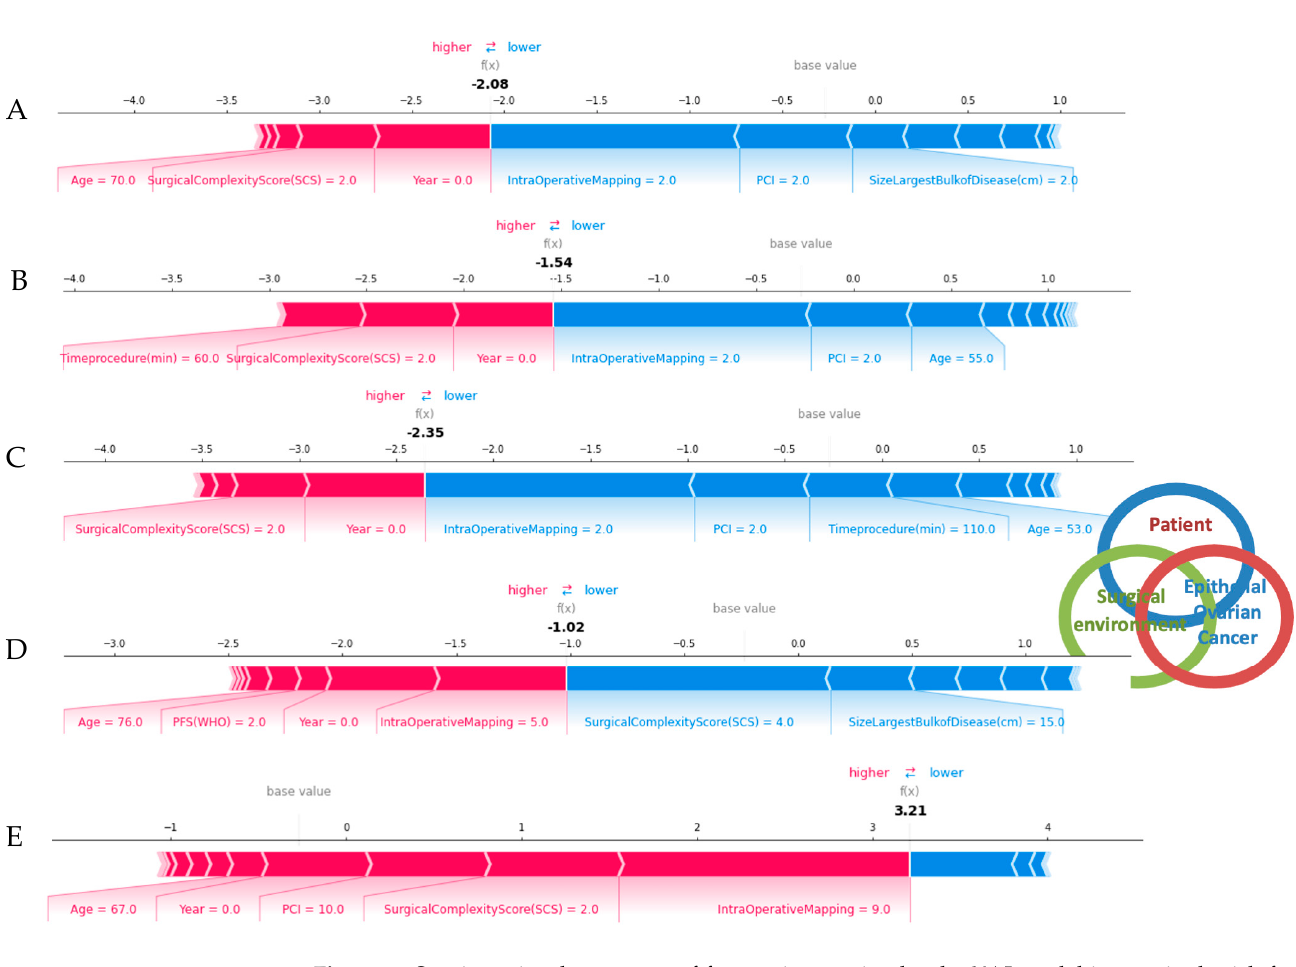
Figure 5. Succinct visual summary of feature integration by the XAI model into a single risk for R0 resection prediction. The SHAP force plots illustrate examples of explained risks for individual patients. For R0 resection risk, blue features have values that increased the risk, while red features decreased the risk. The combination of impacts of all features is the predicted R0 prediction risk. ( A – D ) The odds for R0 resection range between 1.54 and 2.35 times higher than expected ( E ). The odds for incomplete cytoreduction are 3.21 times higher than expected. Each feature impact value represents the change in risk when that feature’s value is known versus unknown. These examples clearly demonstrated the complex interactions between patients and ovarian cancer specific features in a dynamic well supported surgical